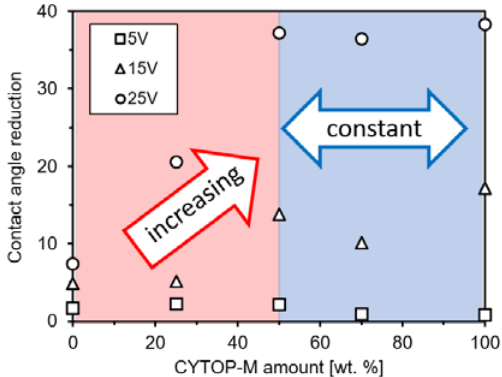
Figure 8. Correlation graph between contact angle reduction and CYTOP-M amount. Square dots mean 5 V applied, triangle dots 15 V applied, and circle dots 25 V applied.